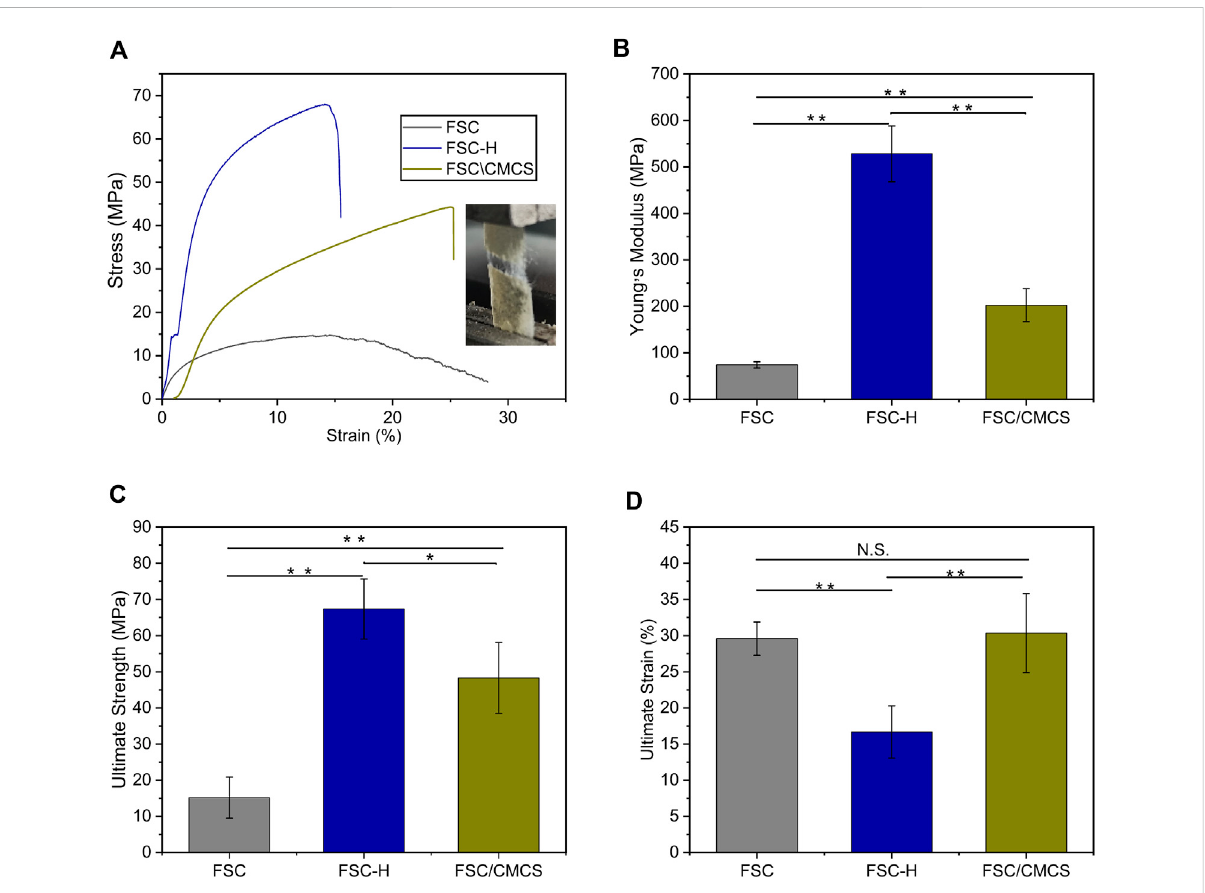
FIGURE 5 Stress – strain curves and images. (A) Stress – strain curves and images of the setup used to stretch the samples and measure their tensile mechanical properties. (B) Young ’ s modulus histograms. (C) Ultimate strength histograms. (D) Ultimate strain histograms. N.S.: no signi fi cant difference. (* p < 0.05, ** p < 0.01). The error bar: mean ± SEM ( n =